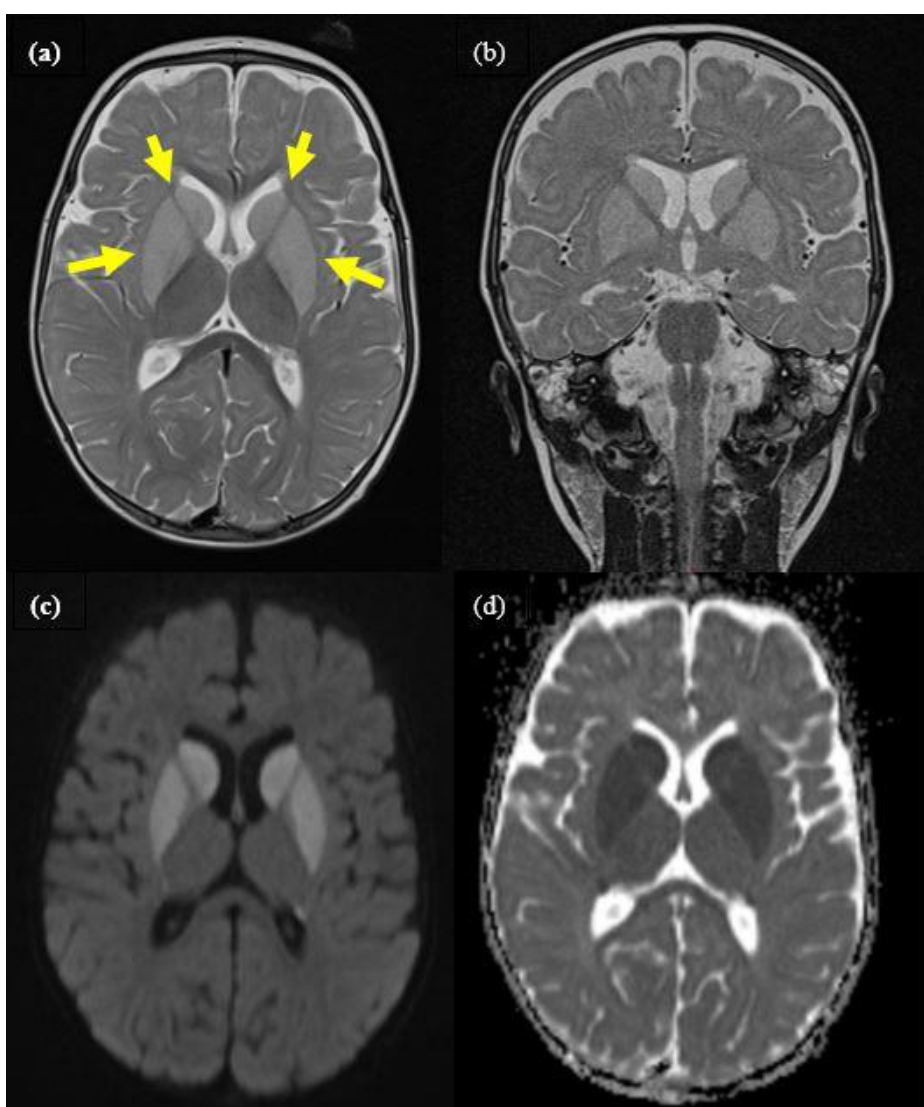
Figure 1. Cranial MRI of patient 1 during encephalopathic crisis at the age of 9 months, showing distinct bilateral signal alteration of caudate, putamen, and pallidum (yellow arrows). ( a ): axial T2, ( b ): coronar T2, ( c ): axial diffusion weighted (DWI), ( d ): ADC-map imaging.